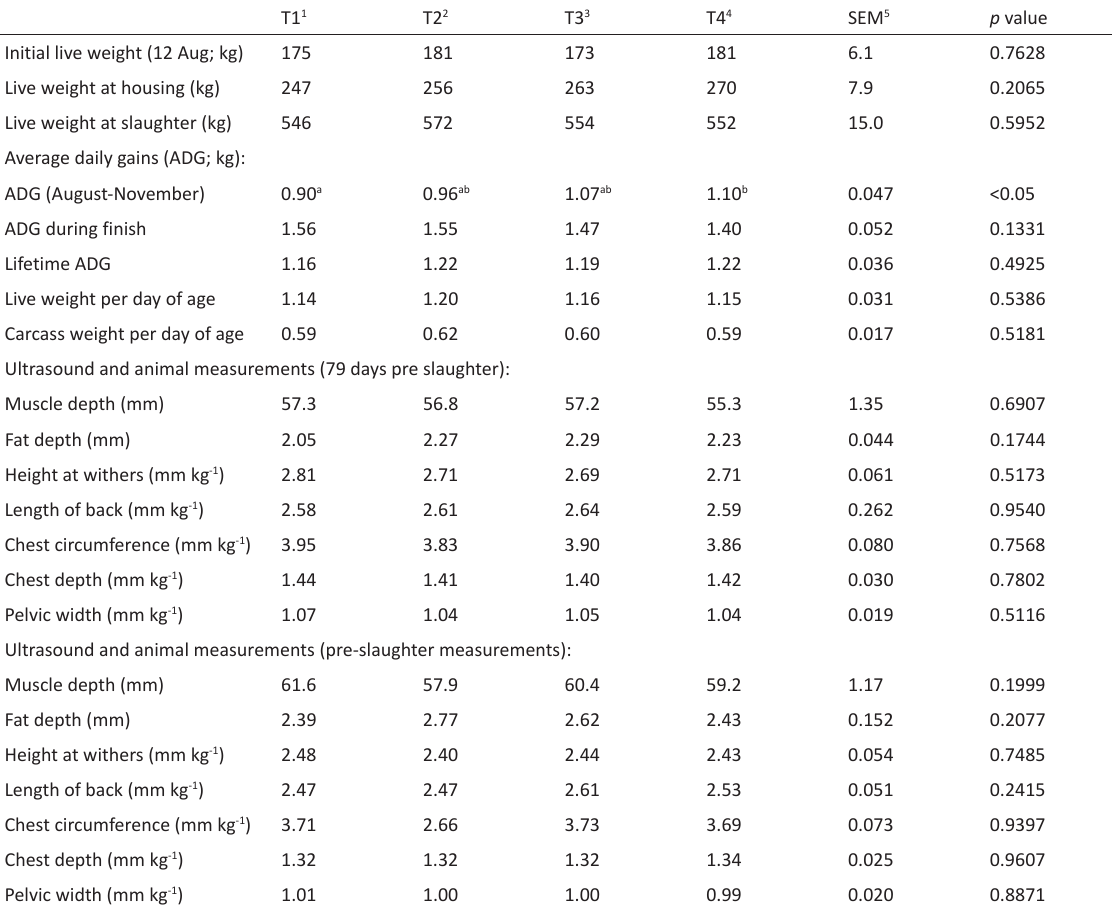
Table 3. Effects of finishing regime on the animal and carcass performance of Holstein-Friesian bulls slaughtered at 15 month of age T1